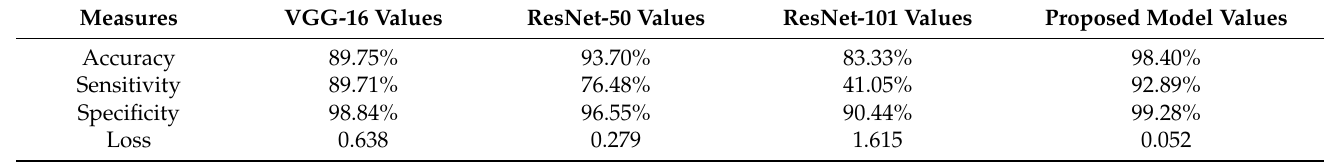
Table 3. Training success rates of the VGG-16, ResNet-50, and ResNet-101 models and the proposed model.